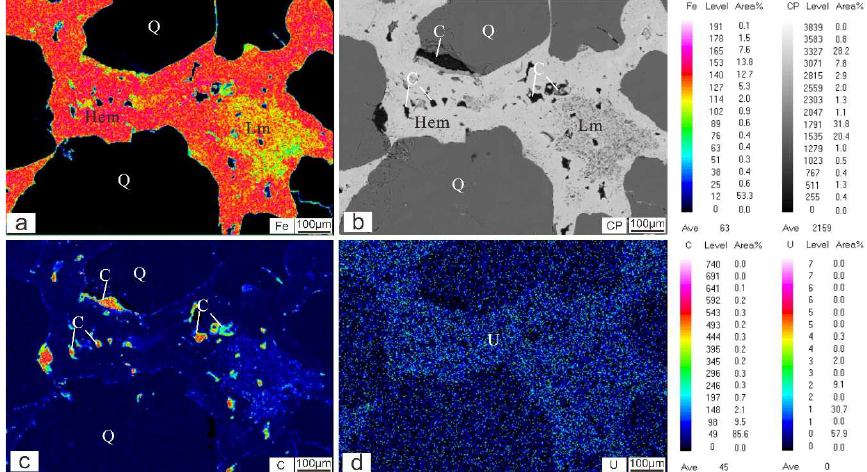
Figure 5. Element distribution of ferruginous sandstone in Wajid Group (Y5.1/SR08). ( a ) Distribution map of iron element content, including hematite in red area with high iron concentration and